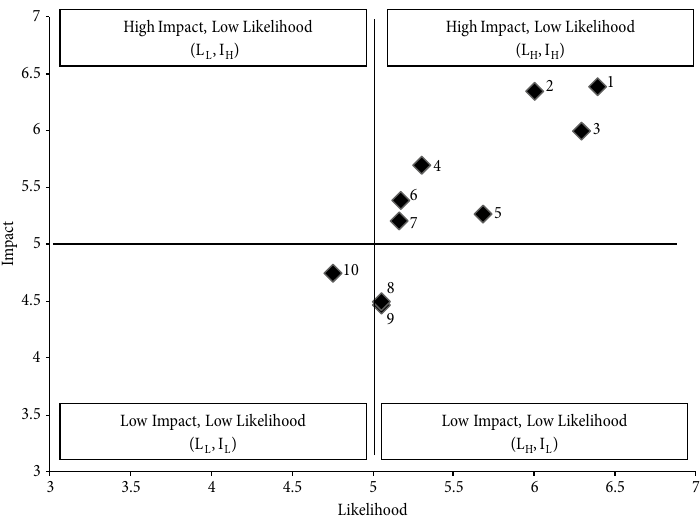
Fig. 1. Likelihood and impact of the top 10 critical network risks: 1 – Lack of trust & commitment; 2 – Different interest & opinion; 3 – Inaccurate information delivery; 4 – Occurrence of dispute; 5 – Ex- tensive subcontracting; 6 – Lack of coordination & communication; 7 – Subcontractor’s subcontracting; 8 – Different work practices; 9 – Different cultural norms; 10 – Lack of risk management